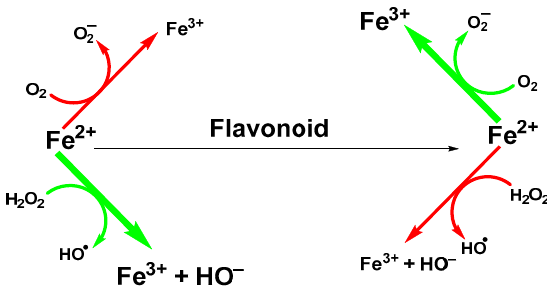
Figure 2. Suppression of Fenton reaction by flavonoids.